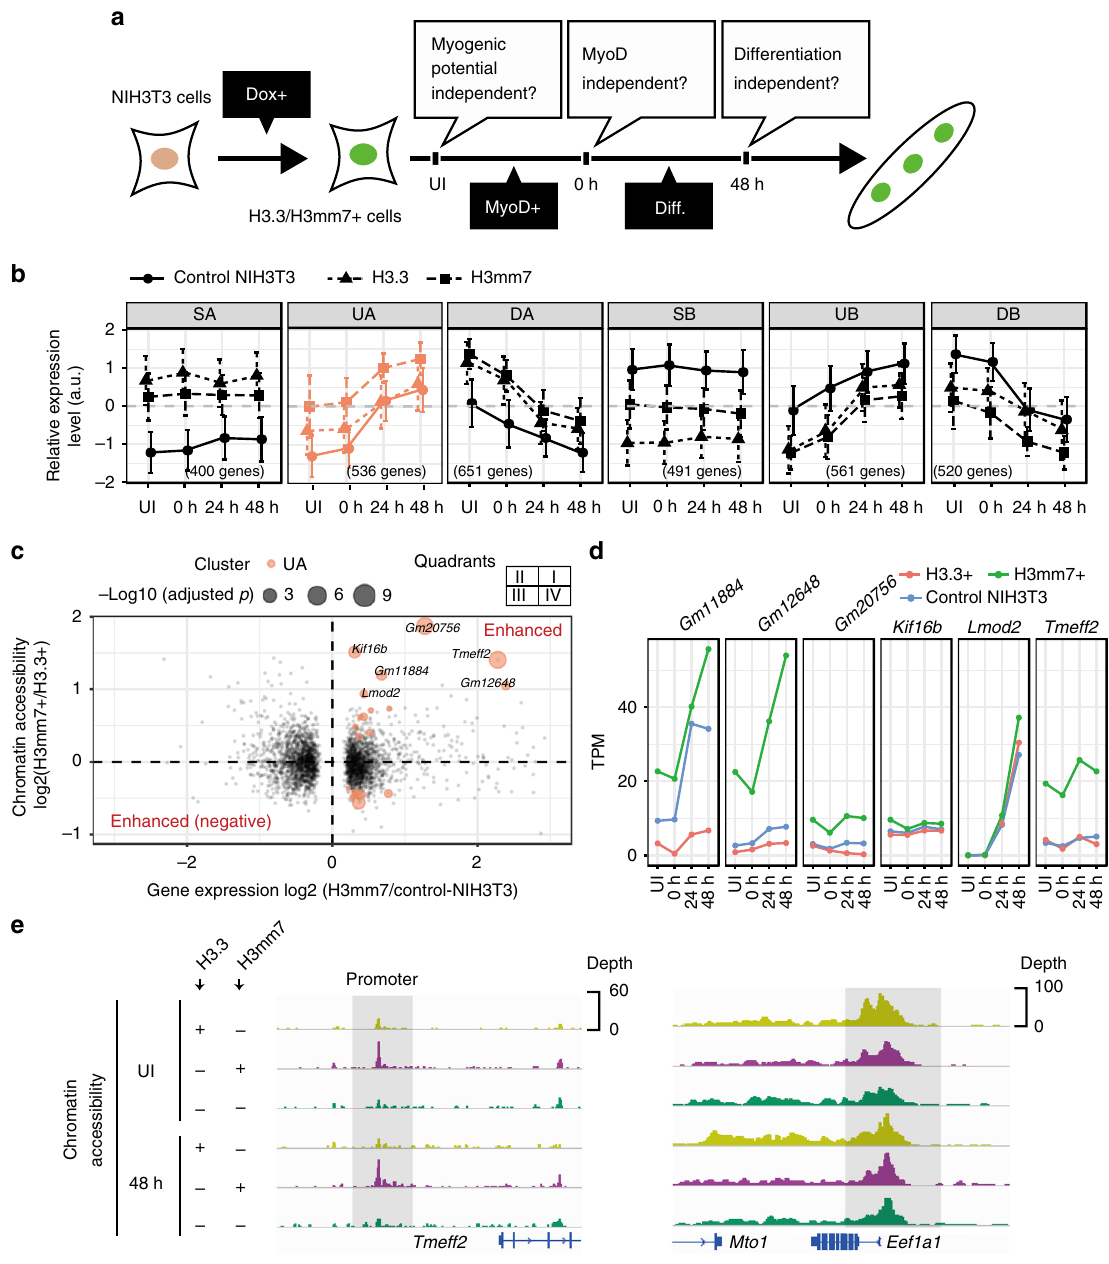
Fig. 3 The incorporation of H3mm7 enhances activated gene expression by increasing chromatin accessibility. a Trans-differentiation model by MyoD infection using H3mm7/H3.3-GFP-expressing NIH3T3 cells. This model was utilized to con fi rm each dependency for exerting the function of H3mm7 on the inherent cell lineage (skeletal muscle potential), transcription factor (MyoD), and differentiation stimuli (serum starvation). b The six types of gene expression patterns in time-series RNA-seq data of NIH3T3 cells. The plot was created as in Fig. 2b. The error bars indicate ±1 SD of the genes ( n : the number of genes in the clusters) c Marked enhancement of gene expression occurred in activated genes during differentiation (cluster UA). The scatter plot of log2-transformed fold change of gene expression (H3mm7 + vs. WT cells, through time) and chromatin accessibility changes (H3mm7 + vs. H3.3 + cells, through time) are shown. The colors correspond to the clusters in b . The sizes of the points are proportional to − log10 (adjusted p -values of chromatin accessibility change). Enhanced: upregulated genes in control NIH3T3 cells over time with higher expression levels and higher accessibility in H3mm7 + cells compared with H3.3 + cells. Enhanced (negative): downregulated genes in control NIH3T3 cells over time with lower expression levels and lower accessibility in H3mm7 + cells compared with H3.3 + cells. d The expression levels of genes that showed marked enhancement. The expression levels are calculated as transcripts per million (TPM). e IGV snapshot of ATAC-seq shows increased chromatin accessibility at an H3mm7 incorporated − / − + / + two major components LD1 ( fi rst component of LDA; corre- and H3mm7 , and subsequently the between H3mm7 sponding to A and B) and LD2 (U, D) in contrast to the other upregulation/downregulation in differentiation, were indeed the minor ones (LD3, 4, and 5). The singular values of LD1 and LD2 two major components that explain the result of k -means were 123.98 and 50.07 (84.3% and 13.8% of total between-class clustering. variance), respectively. This suggested that the rate change (bias)